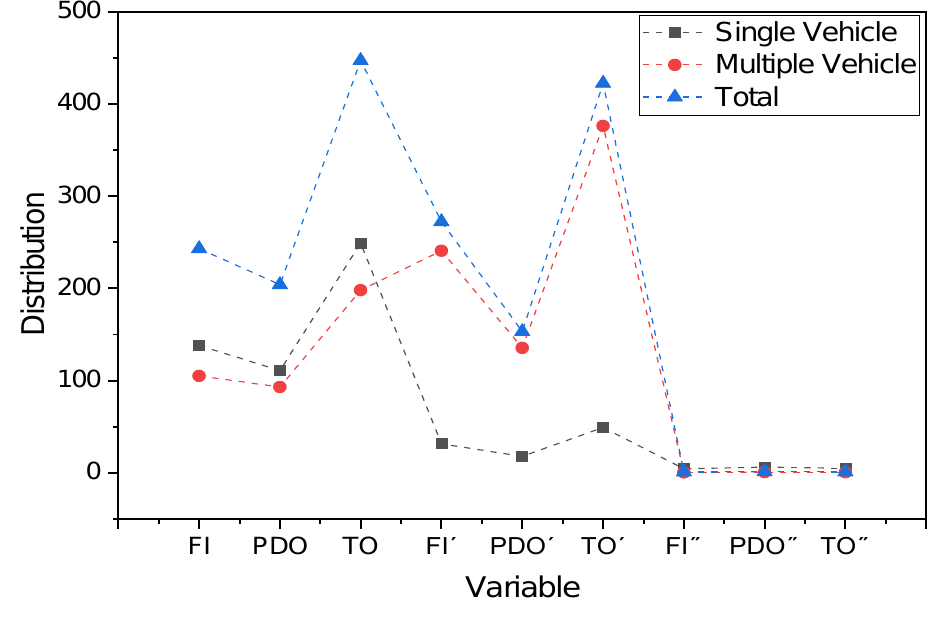
Figure 2. Estimated calibration factors.